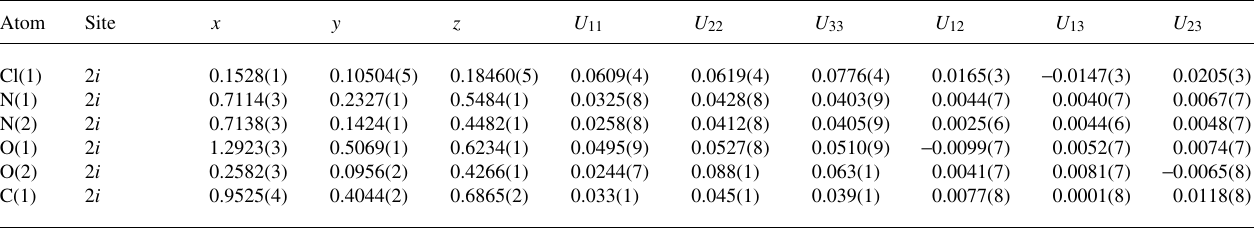
Table 3. Atomic coordinates and displacement parameters (in Å 2 )